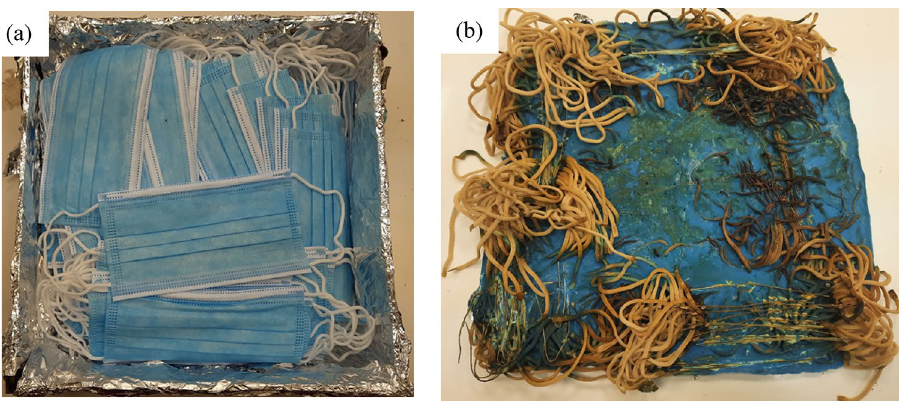
Figure 4. ( a ) The stainless steel mold holding the masks before melting and ( b ) the melted masks showing the unmelted elastic ear